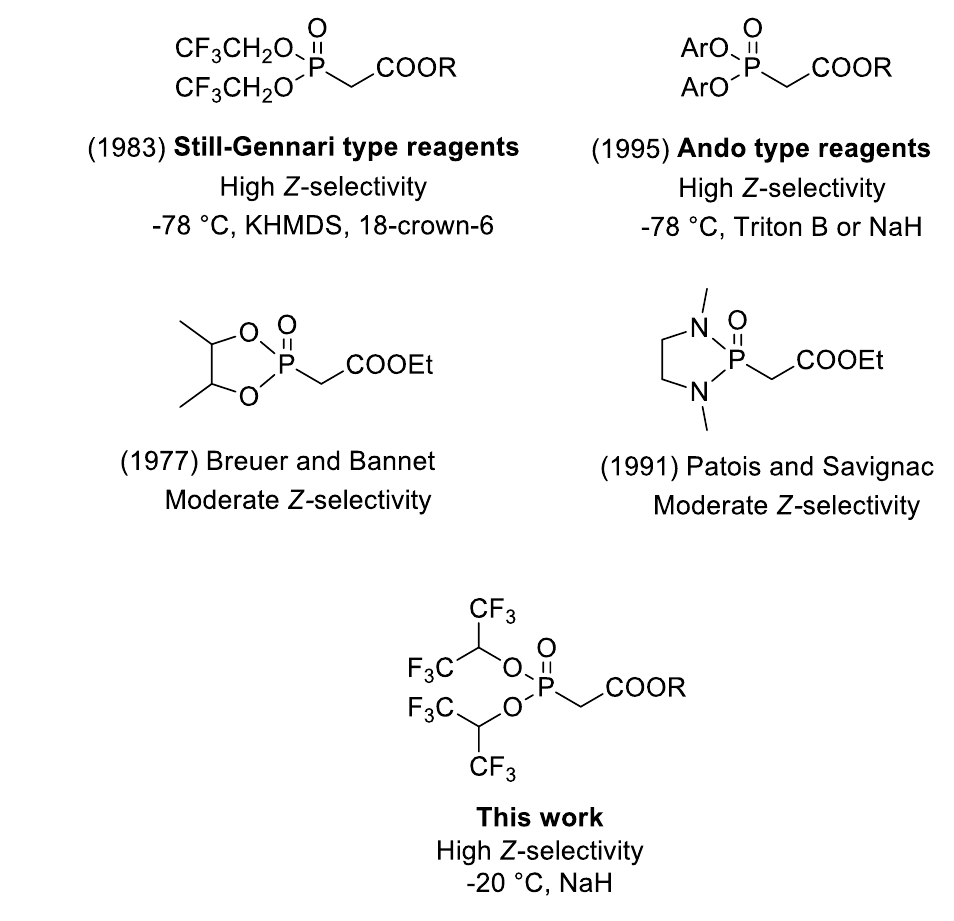
Figure 1. Comparison of Z -selective reagents for the HWE reaction [11 – 14].